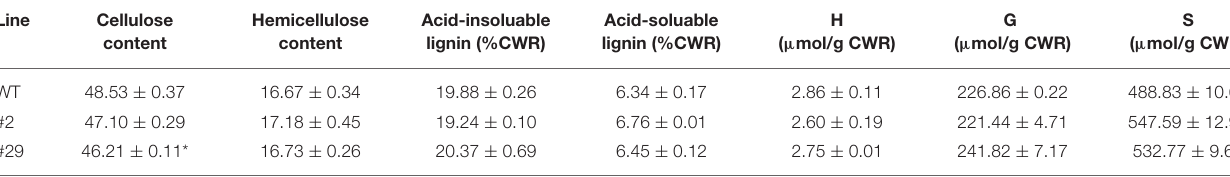
TABLE 1 | Lignin content and compositions in the BLH6a:SRDX overexpression transgenics.